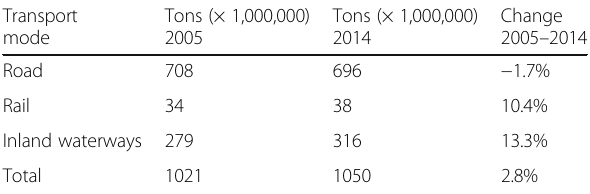
Table 5 Change in transported number of tons per transport mode